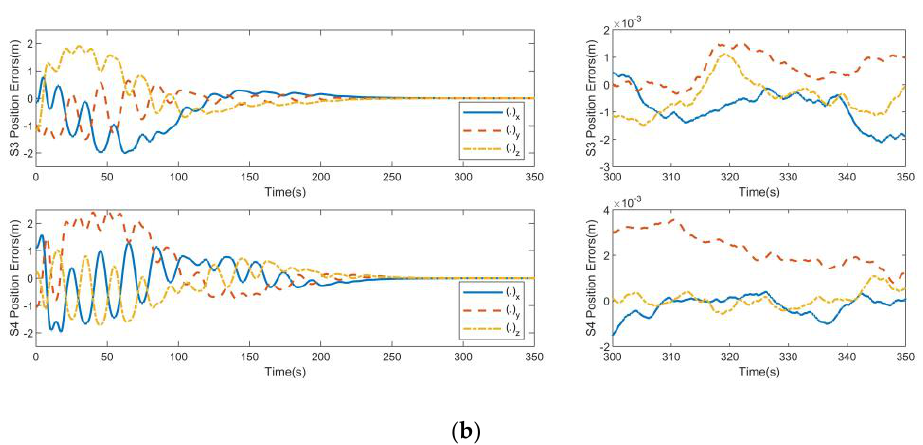
Figure 3. Position errors for non-consistent collaborative control: ( a ) S1 position errors and S2 posi- tion errors; ( b ) S3 position errors and S4 position errors.